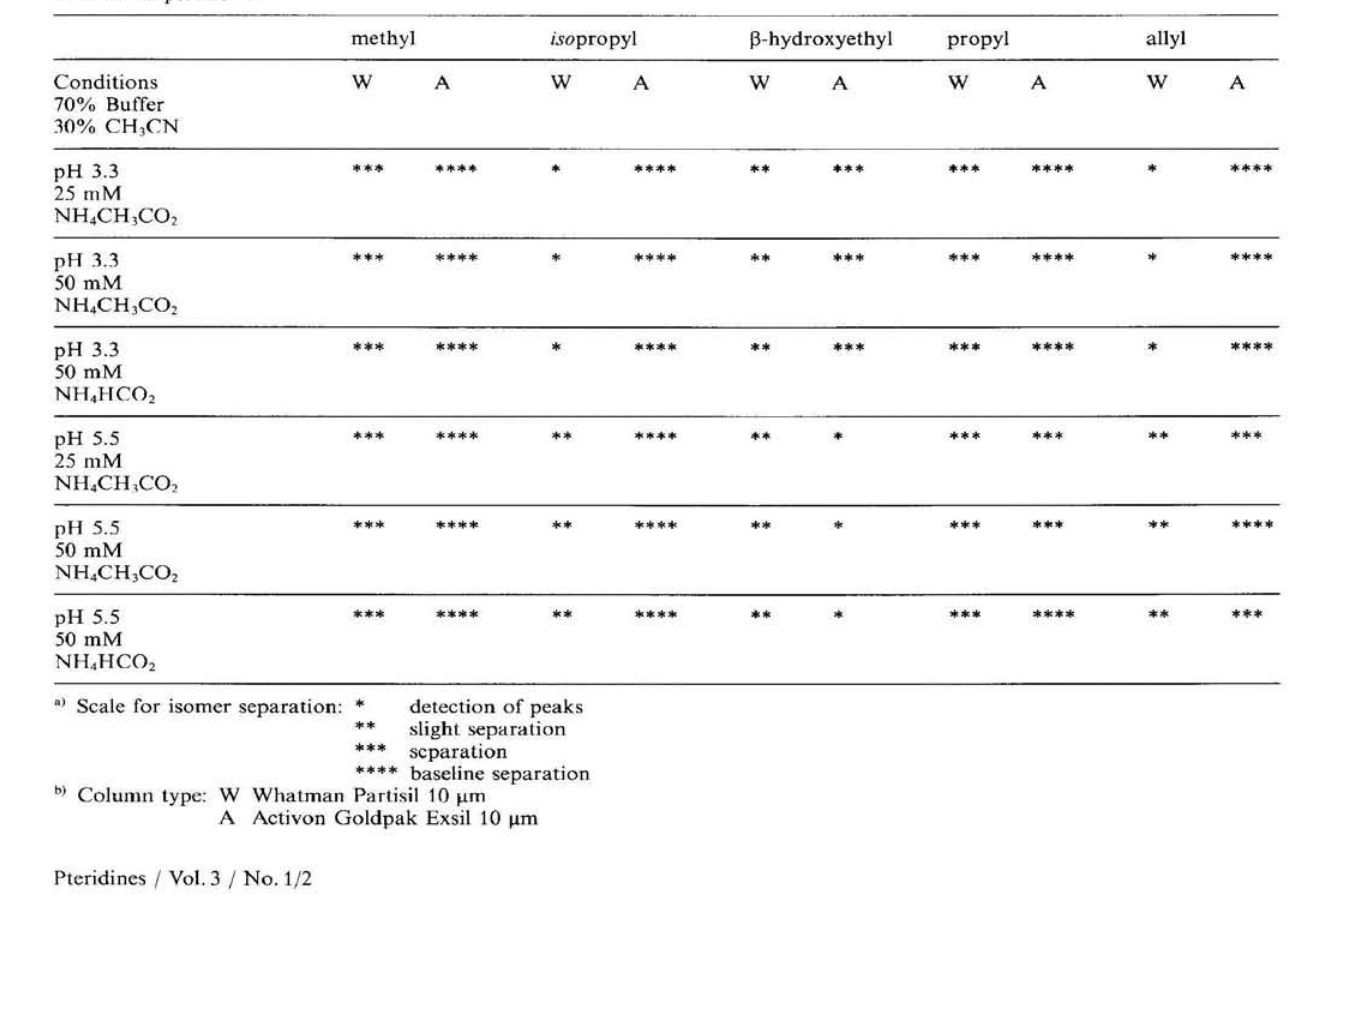
Table 1. The effect of column type, pH, buffer type and concentration on the separation of 6- and 7- methyl isomers of some 8- substil uted-pterins."'' b